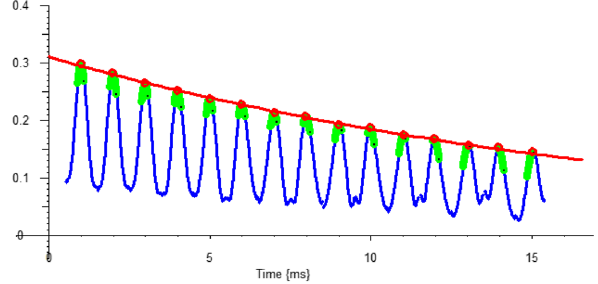
Fig. 4 An example of a chain of NMR Pulses in a Carr–Purcell–Mei- boom–Gill sequence (CPMG) pulse sequence, for water in sol-gel silica pores. Each echo peak has been polynomial fitted, the poly- nomial algebraically solved to find the peak (red dots), and an exponential fit made to the peaks, giving the reduced T 2 of the water due to surface relaxation in the